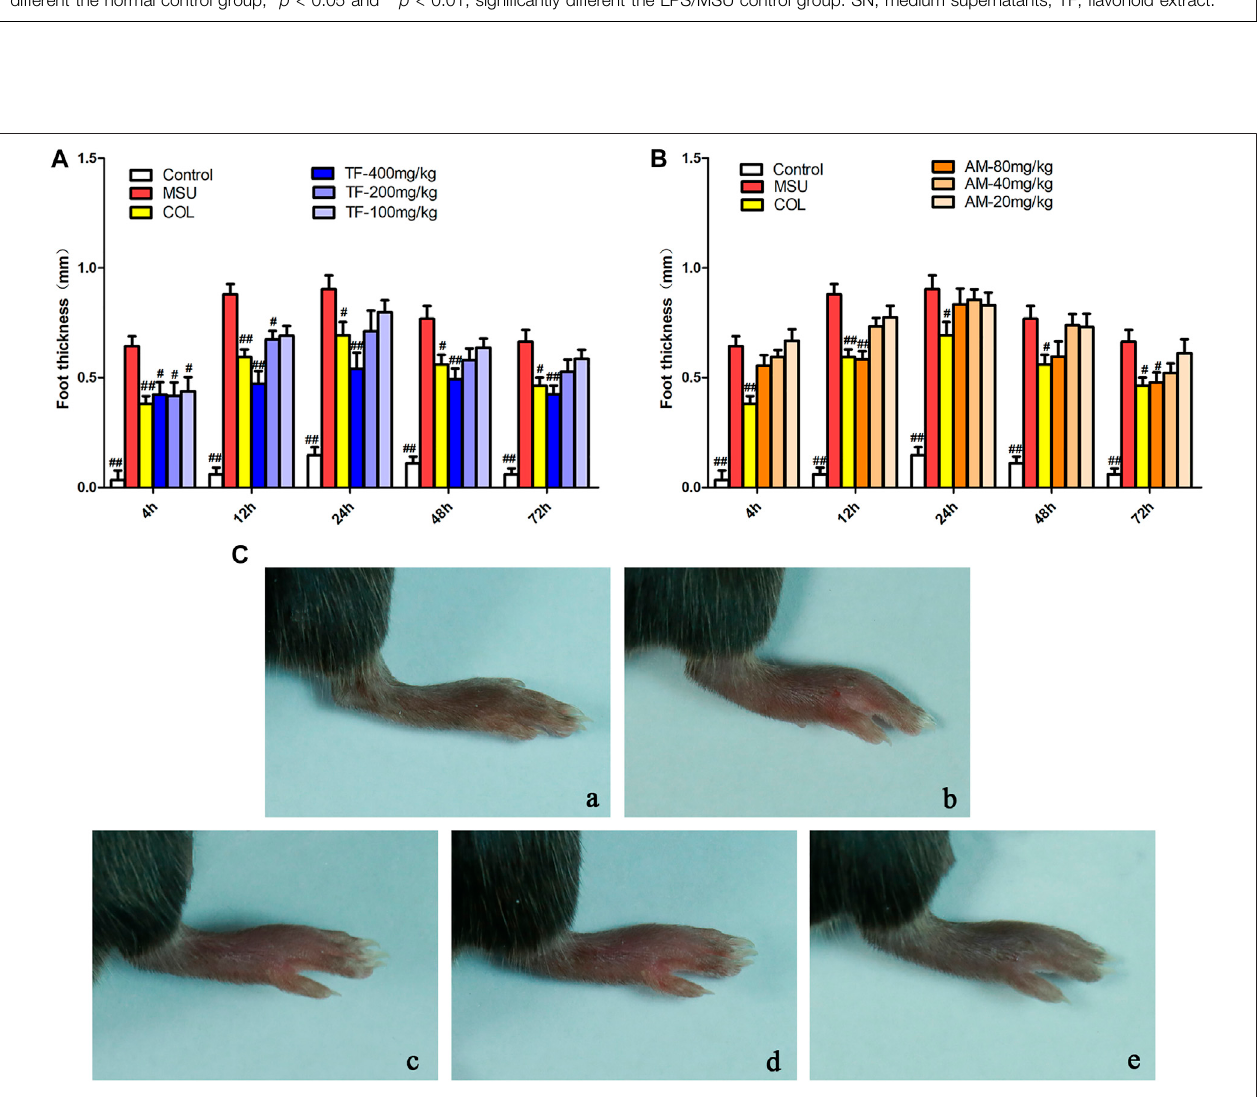
FIGURE11| EffectsofTFandAMonpawswellinginMSU-inducedmice. (A,B) Timecourseoffootpadthicknessgaincomparedwiththefootpadthicknessatthe 0 h time point per group; (C) Paw joint in fl ammation severity was observed macroscopically. a, Normal control group; b, MSU control group; c, colchicine group; d, TF- 400 mg/kg group; e, AM-80 mg/kg group. * p < 0.05 and ** p < 0.01, signi fi cantly different the normal control group; # p < 0.05 and ## p < 0.01, signi fi cantly different the LPS/MSU control group. TF, fl avonoid extract; AM, amento fl avone.